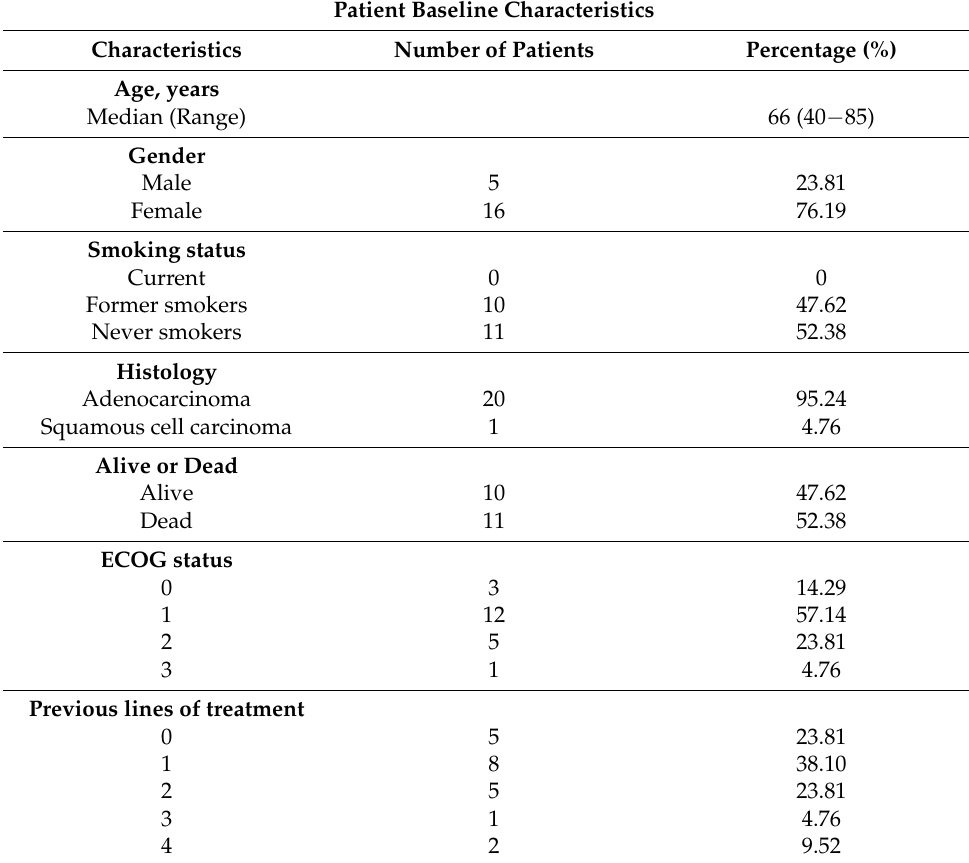
Table 1. Patient demographics and